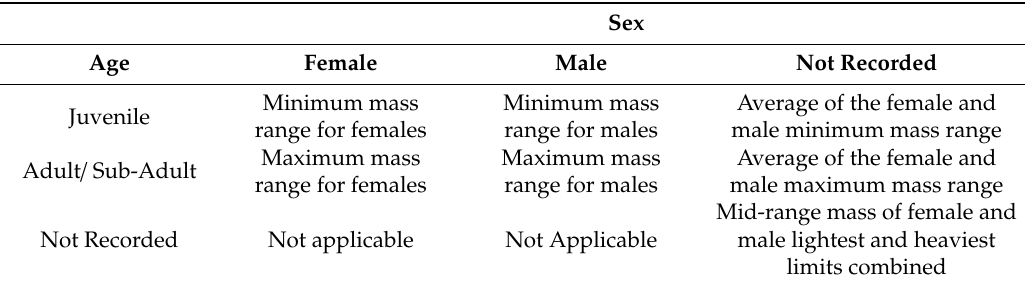
Table 3. Criteria used for body mass determination of by-catch. (Note: There was no occurrence of sex being recorded without